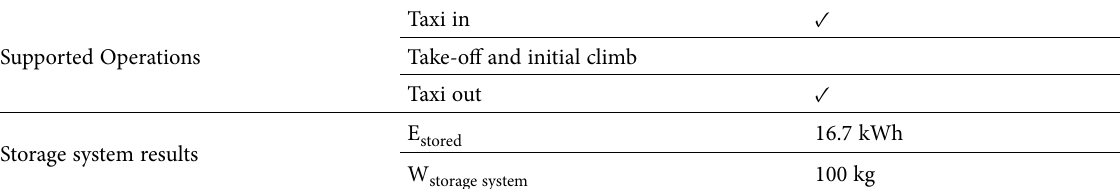
Table 5. Storage system sizing to support Green Taxi